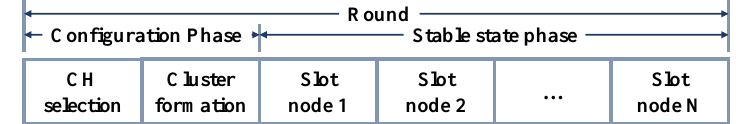
Figure 2. LEACH protocol